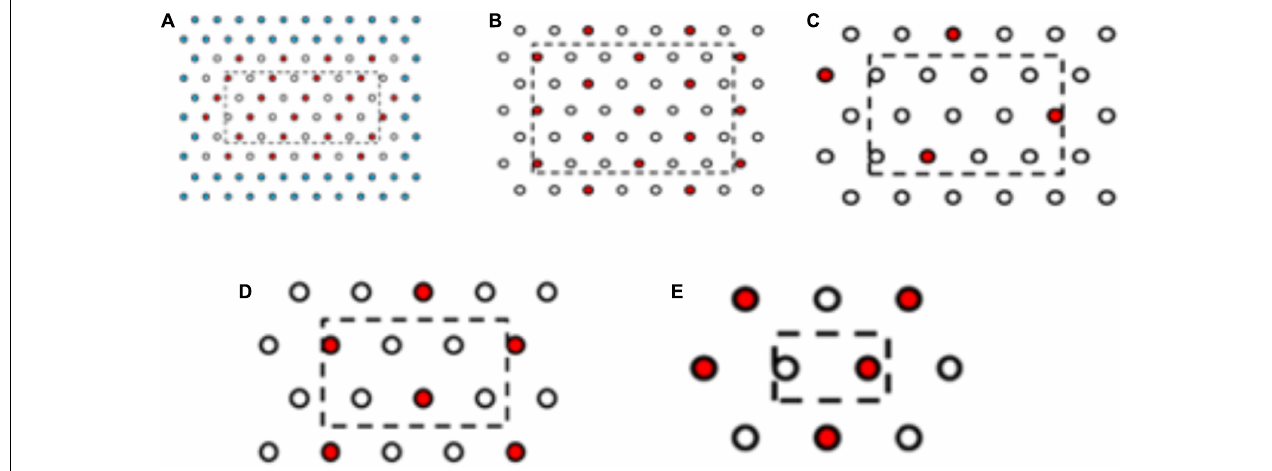
FIGURE 2 | Planting arrangements at selected densities and proportions of resistant and susceptible seed families. (A) R:S, 3:3 plant ratio, 1,100 plants m − 2 , (B) R:S 4:2, 560 plants m − 2 , (C) R:S 6:1, 300 plants m − 2 , (D) R:S 4:2 200 plants m − 2 , (E) R:S 3:3 100 plants m − 2 . Red and white spots represent the plant position for plants from the most resistant and the most susceptible seed family phenotypes are interchangeable. Three replicate boxes were created for density (A–D) and six replicate boxes for density e. Due to the high seedling volume required for the 1,100 plants m − 2 treatment, two rows of spacer plants (blue) were added to the outside of the layout, spacer plants were from seed family 153. Plants within the dashed line box were harvested, plants outside of the box acted as edge effect plants.